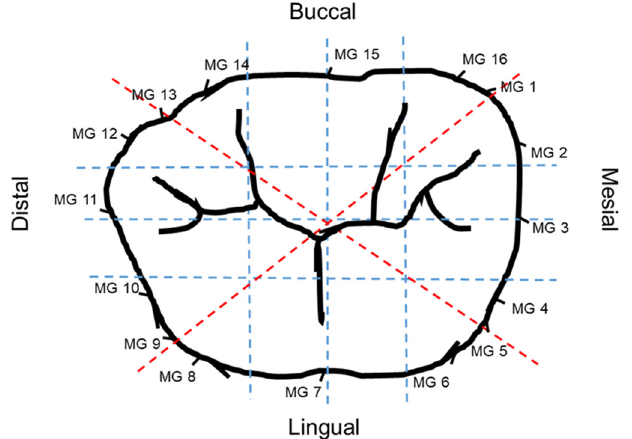
Figure 3. Schematic diagram (occlusal view of the crown) showing the different mesio-distal and bucco-lingual sagittal sections used for crown marginal and internal gap evaluation, represented by blue and red dotted lines. MG 1 to MG 16 represent the marginal gap measurement sites all around the crown for different sections.